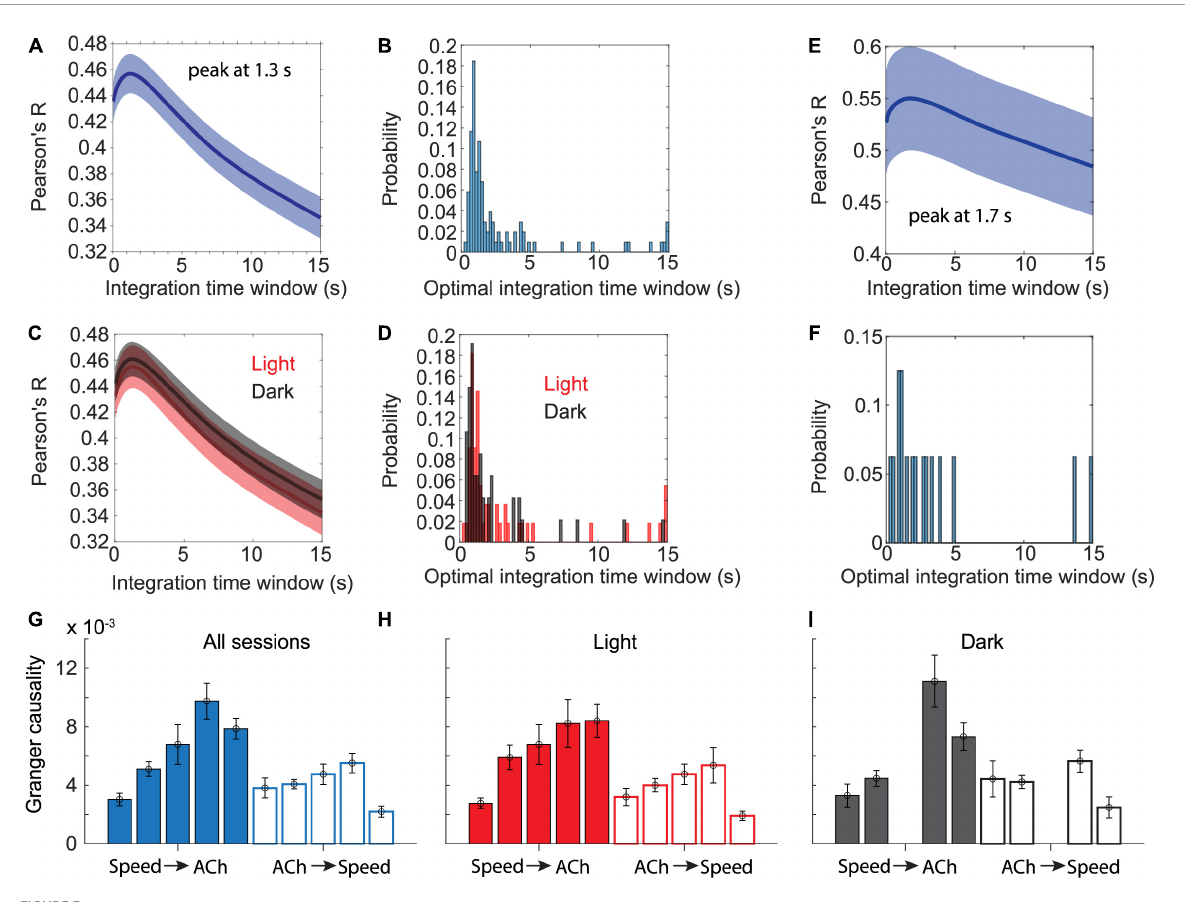
FIGURE3 Temporal dynamics in cholinergic activity align with changes in movement speed. (A) Data show Pearson’s correlation coefficients between moving averages of cholinergic activity and the animal’s movement speed as a function of the time window used for computing the moving average of cholinergic activity. Blue line and shaded area show the mean ± s.e.m. of data from n = 103 sessions from five mice. The average peaks at 1.3-s. (B) Distribution of the optimal time windows, computed for each session, that maximize the correlation between moving averages of cholinergic activity and movement speed. The histogram shows a peak between 0.8 and 1-s. (C,D) Data presented as in (A,B) but comparing data from light (red, n = 55 sessions, five mice) and darkness sessions (black, n = 47, 4 mice). No significant difference was found between light and darkness sessions shown in (C) when comparing values at 1.3-s, t (100) = -0.192, p = 0.85. (E) Subset of data presented in (A) that only includes n = 16 sessions from three mice, in which the mice spent at least two thirds of the session time engaged in stationary behaviors (running speed < 3-cm/s). The average peaks at 1.7-s. (F) Same subset of data on stationary activity as shown in (E). Histogram shows the distribution of the optimal time windows, computed for each session, that maximize the correlation between moving averages of cholinergic activity and neck movement speed during stationary activity. (G-I) Granger causality magnitudes comparing Granger causality directions from the logarithm of movement speed to cholinergic activity (Speed → ACh) and vice versa (ACh → Speed) across animals. Each bar shows data from one mouse. Data are represented as mean ± s.e.m. across sessions. (G) Data from all sessions. (H) Data on light sessions only. (I) Data on dark sessions only. Note that one mouse was not recorded during darkness (see Tables 4 , 5 and Supplementary Table 1 for